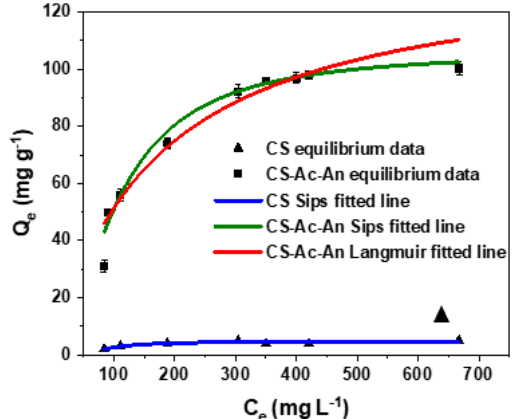
Figure 6. Adsorption isotherms for chitosan ( (cid:78) ) fitted to the Sips model and CS-Ac-An ( (cid:4) ) fitted to the Langmuir and Sips models at ambient pH (6.5–7) and 23 ◦ C. Cu(II) concentration: 50–800 mg L − 1 , contact time: 24 h, adsorbent dosage: 5 mg. The adsorption profile for chitosan is shown for comparison. Table 1. Sips model adsorption parameters for Cu(II) uptake with CS and CS ‐ Ac ‐ An at 23 °C.